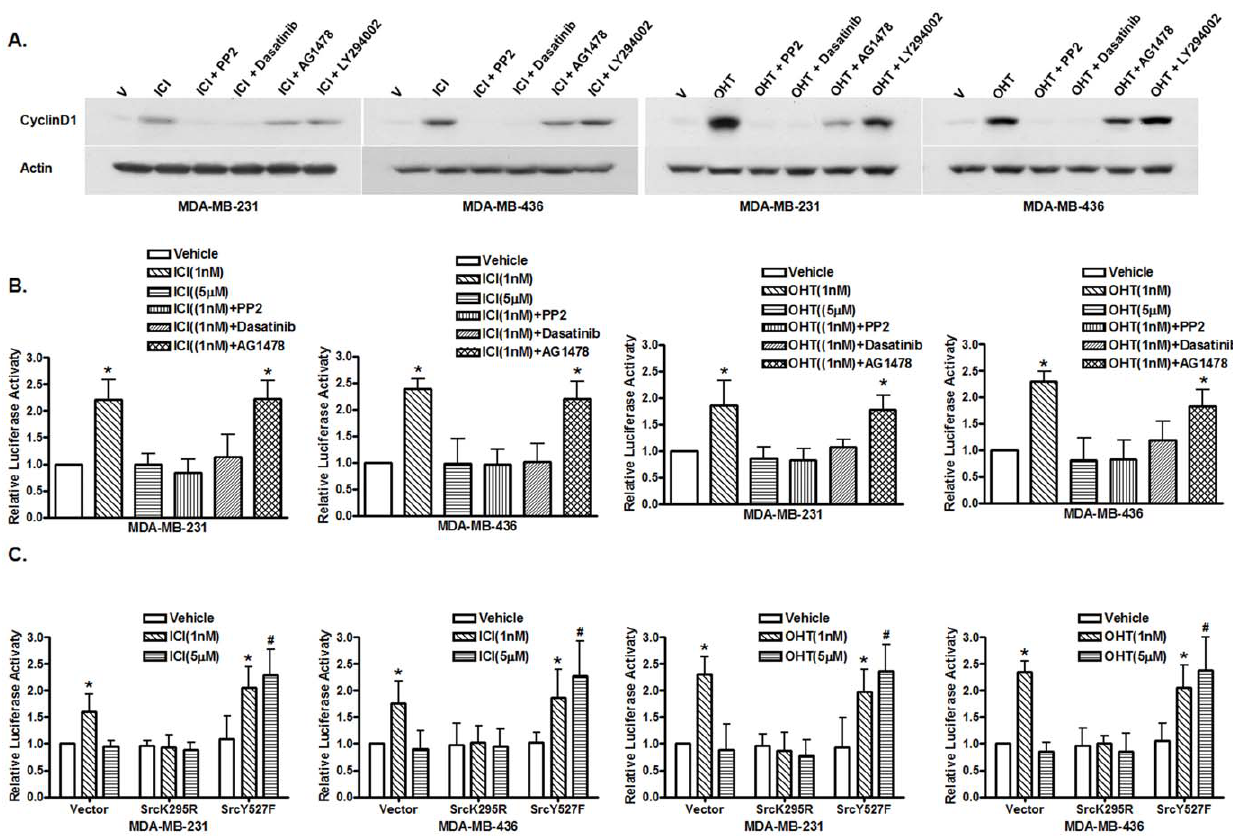
Figure 4. Src is involved in antiestrogen-induced Cyclin D1 expression. (A). Western blot analysis of Cyclin D1 expression in MDA-MB-231 and -436 cells. Cells were treated with vehicle (ethanol) and antiestrogens alone or together with the Src inhibitors PP2 and dasatinib, the EGFR inhibitor AG1478 and PI3K inhibitor LY294002. Cell lysates were analyzed with anti-Cyclin D1 antibody and anti-Acin antibody was used to ensure equal loading. The experiment was repeated three times, and the representative results are shown. (B). Src inhibitors inhibit antiestrogen-induced Cyclin D1 promoter activity. ER-negative breast cancer cells were transfected with the luciferase reported plasmid Cyclin D1 pl-963 that containing a luciferase gene driven by the Cyclin D1 promoter. Transfected cells were treated with vehicle (ethanol), 1 nM or 5 m M of antiestrogens, and 1 nM of antiestrogens together with different inhibitors. The luciferase activities were assayed and normalized using a cytomegalovirus promoter-driven Renilla luciferase plasmid. Columns: means of the relative luciferase activity in cells treated with vehicle that is arbitrarily set as 1.0 from four independent experiments; bars, SE. *, p , 0.05, for cells treated with vehicle (V) vs 1 nM of antiestrogens, or vehicle (V) vs 1 nM of antiestrogens plus AG1478. (C). The involvement of Src in antiestrogen-induced Cyclin D1 promoter activity. Cells were transfected with the luciferase reported plasmid Cyclin D1 pl-963 together with an empty expression vector or Src mutants, a dominant-negative mutant (SrcK295R) and a constitutively active mutant (SrcY527F). Transfected cells were treated with vehicle (ethanol), 1 nM or 5 m M of antiestrogens. The luciferase activities were assayed and normalized using a cytomegalovirus-driven Renilla luciferase plasmid. Columns: means of the relative luciferase activity from four independent experiments. Luciferase activity in transfected cells treated with vehicle is arbitrarily set as 1.0; bars, SE. *, p , 0.05, for cells treated with vehicle (V) vs 1 nM of antiestrogens. # , p , 0.05, for cells treated with vehicle (V) vs 5 m M of antiestrogens.